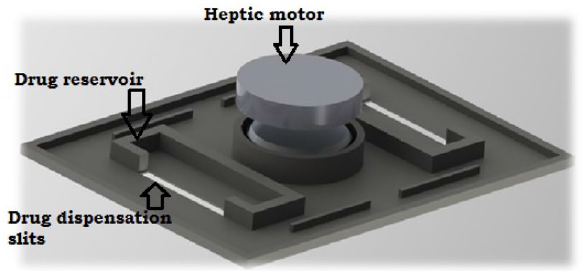
Fig. 3 3D printed device and its